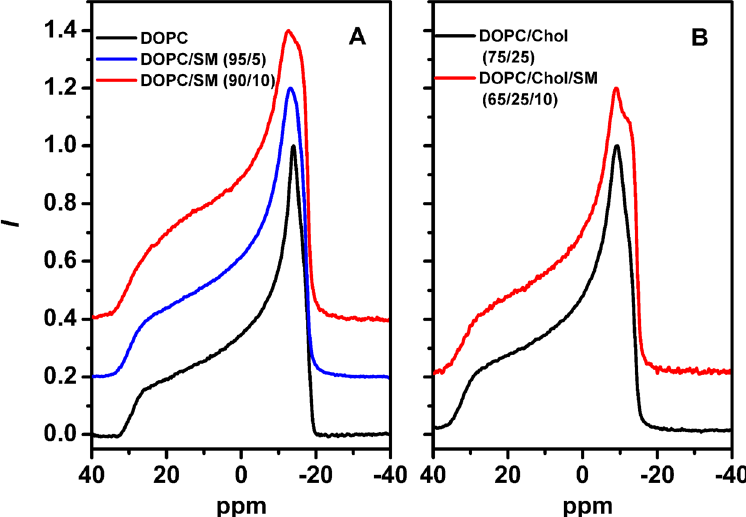
Figure 5. Static 31 P NMR spectra of multilamellar vesicles composed of (left panel) DOPC (black), DOPC/ SM 95/5 (red) and DOPC/SM 90/10 (blue) or (right panel) DOPC/Chol 75/25 (black) and DOPC/Chol/SM 65/25/10 (red) at 298